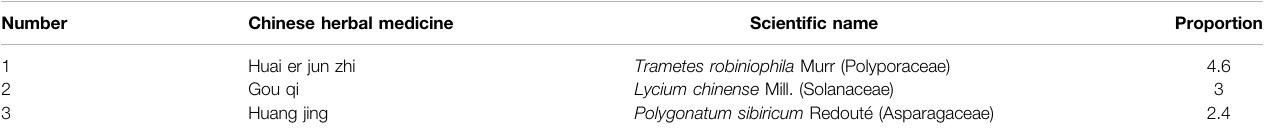
TABLE 4 | Constituents of